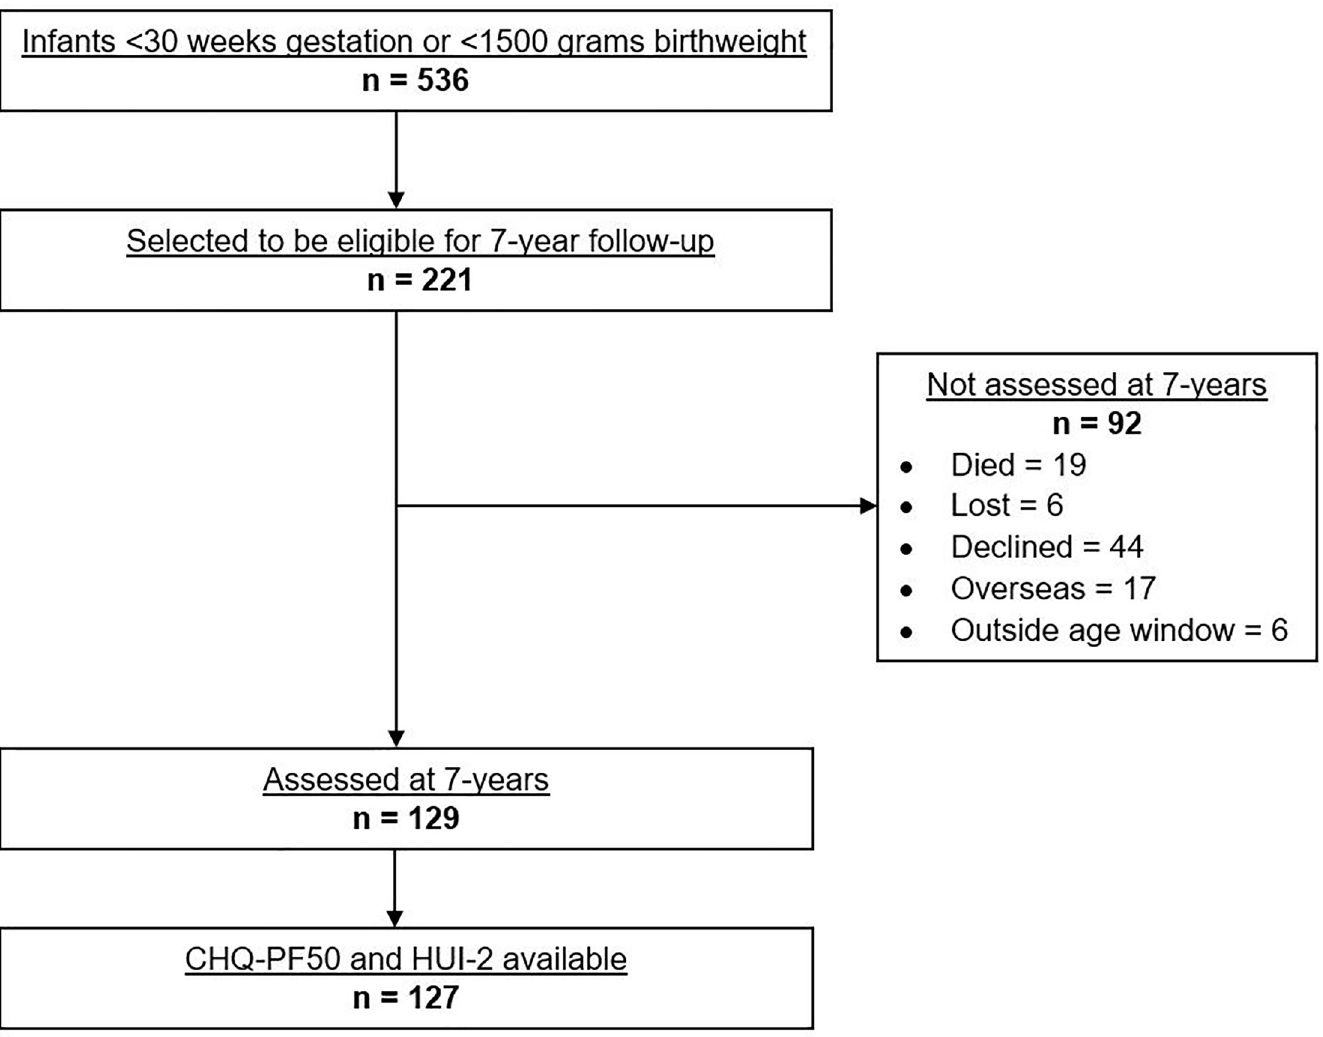
Fig 1. Flow diagram of participants in this follow-up study. CHQ-PF50: Child Health Questionnaire Parent Form 50 questions. HUI-2: Health Utilities Index Mark